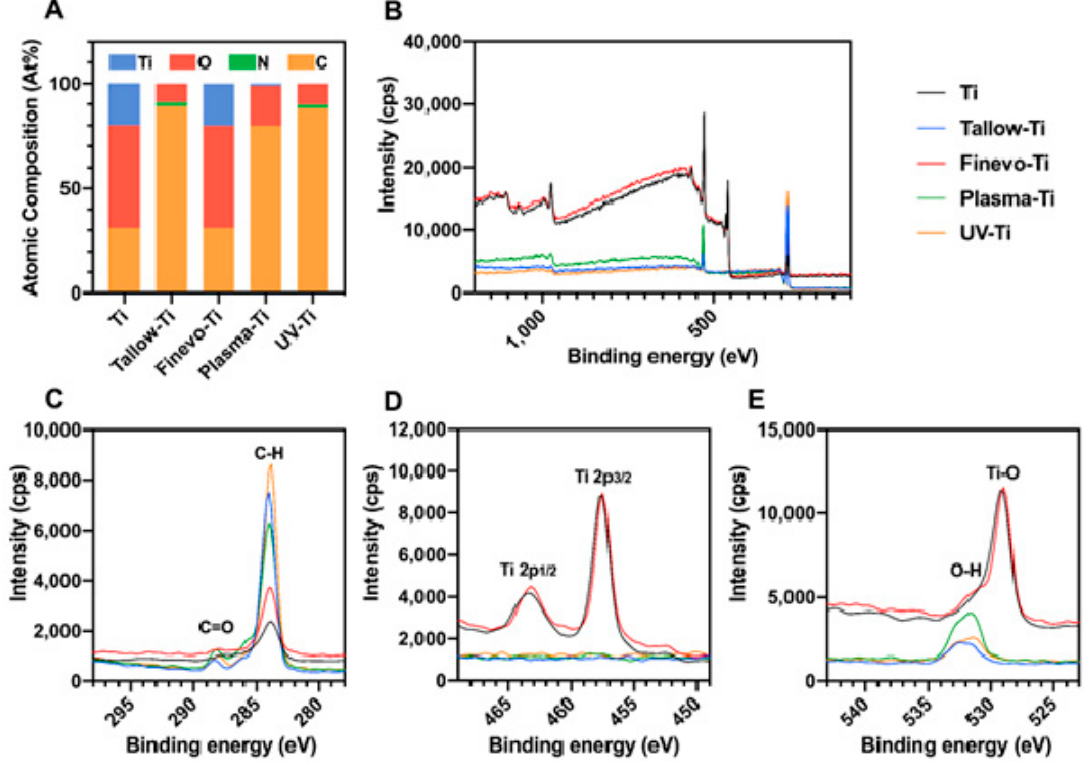
Figure 4. High-resolution chemical analysis of sample surfaces by X-ray photoelectron spectroscopy. ( A ) Atomic percentage of each element on the sample surface. ( B ) High-resolution XPS spectra of sample surfaces. ( C ) C 1s spectra. ( D ) Ti 2p spectra. ( E ) O 1s spectra.